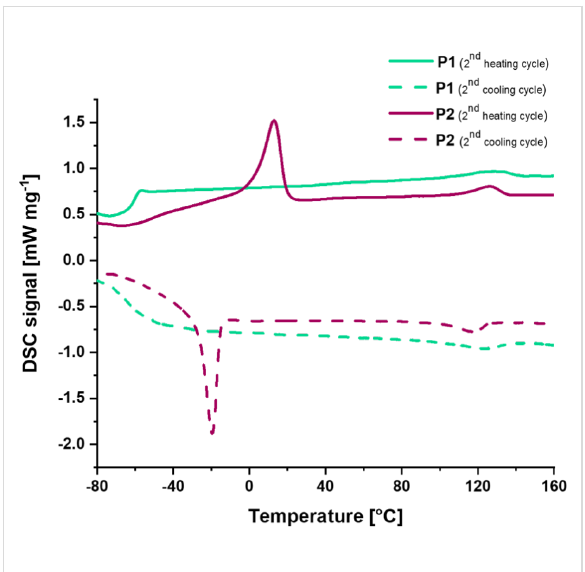
Figure 1: DSC-analysis of the polymers P1 and P2 (second heating and cooling cycle; 20 K/min for heating and cooling) with a glass transi- tion temperature ( T g ) at − 58 °C ( P1 ) and − 51 °C ( P2 ) and the endothermic transition at 129 °C ( P1 ) and 126 °C ( P2 ). In addition, P2 shows a T m at 13 °C.